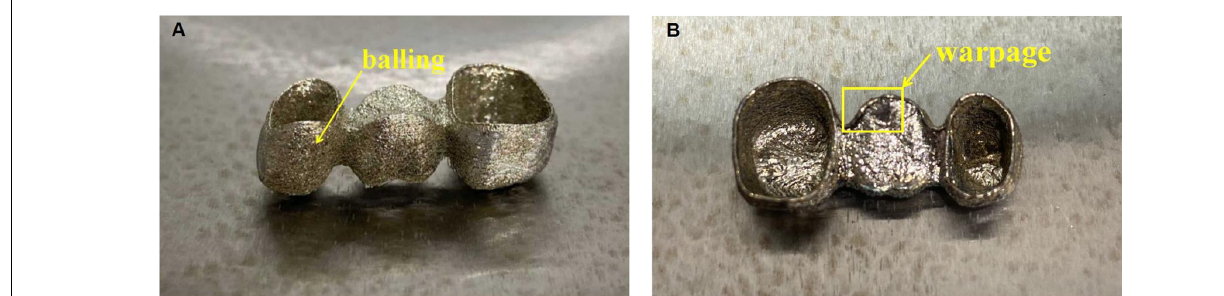
spheroidization and pores. However, if laser power is too high, excessive melting will occur, resulting in warping, deformation and cracking of the formed parts, which will have an adverse effect on the forming quality (Zhang et al., 2017). Scanning speed refers to the moving speed of the laser spot on the powder bed, which directly affects the interaction time between laser and metal powder. Scanning interval refers to the distance between two adjacent parallel scan lines, which determines the overlap